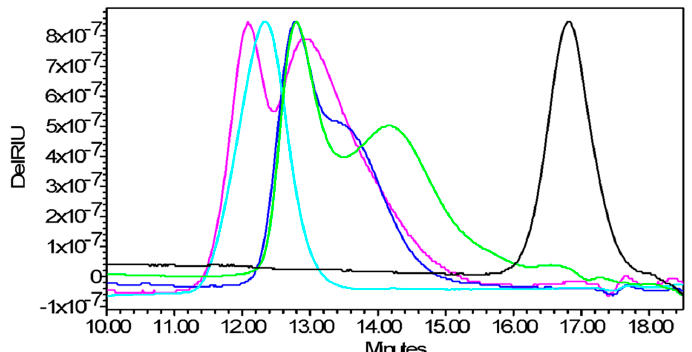
Figure 4. High Performance Liquid Chromatography–Size Exclusion Chromatography (HPLC-SEC) profiles (refractive index detection) of GACox-CRM 197 (green line), GACox-SLO (light blue line), GACox-SpyAD (blue line), GACox-SpyCEP (pink line) conjugates compared to unconjugated GAC (black line). 80 µL of sample injected on a TSK gel G3000 PW XL column; 0.1 M NaCl 0.1 M NaH 2 PO 4 Table 1. Main characteristics of purified GAC conjugates with CRM 197 and GAS proteins. Conjugate GAC/Protein Molar Ratio GAC/Protein w/w Ratio GACox-CRM 197